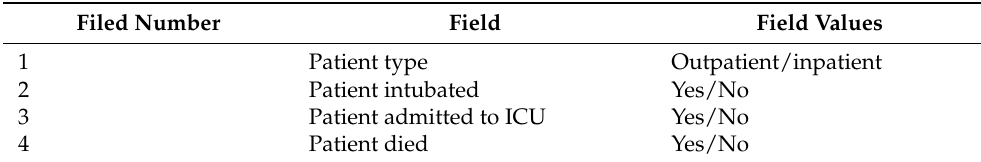
Table 2. COVID-19 patient clinical